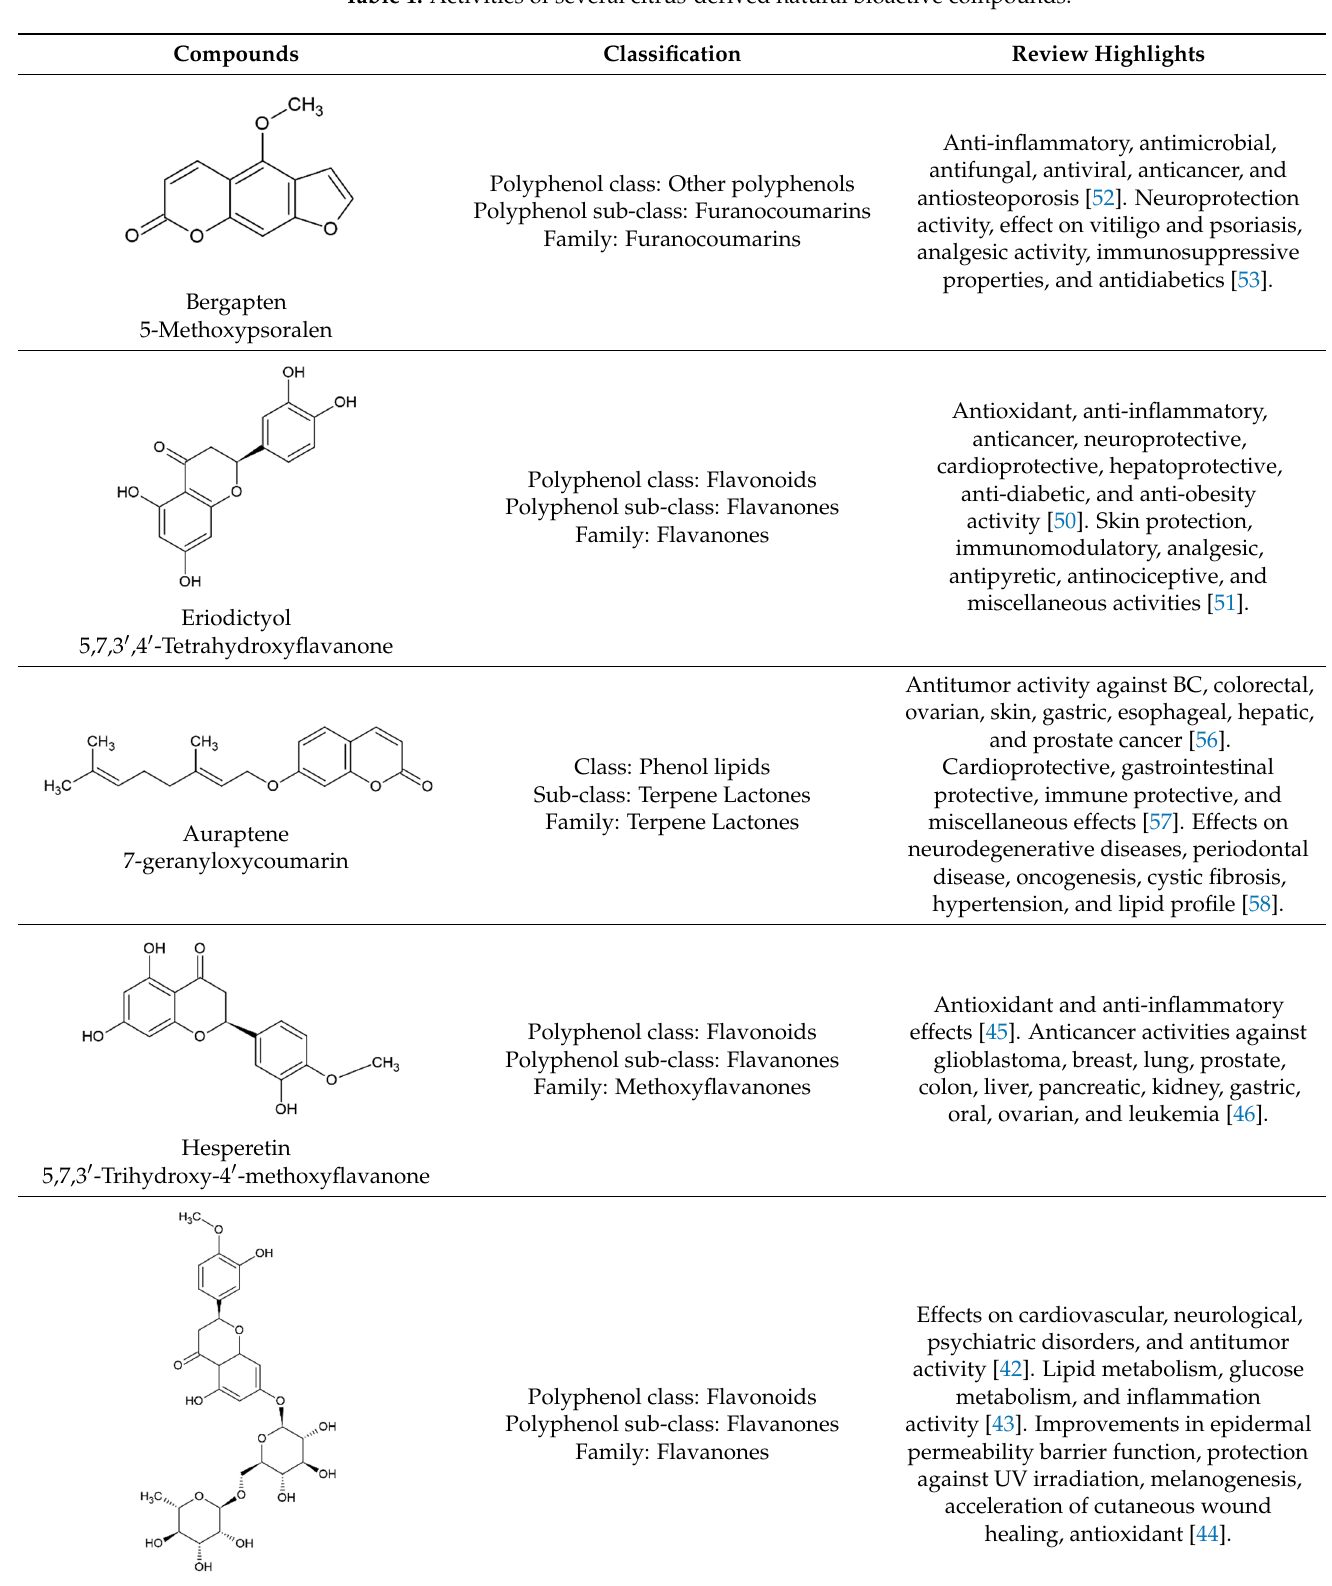
Table 1. Activities of several citrus-derived natural bioactive compounds.